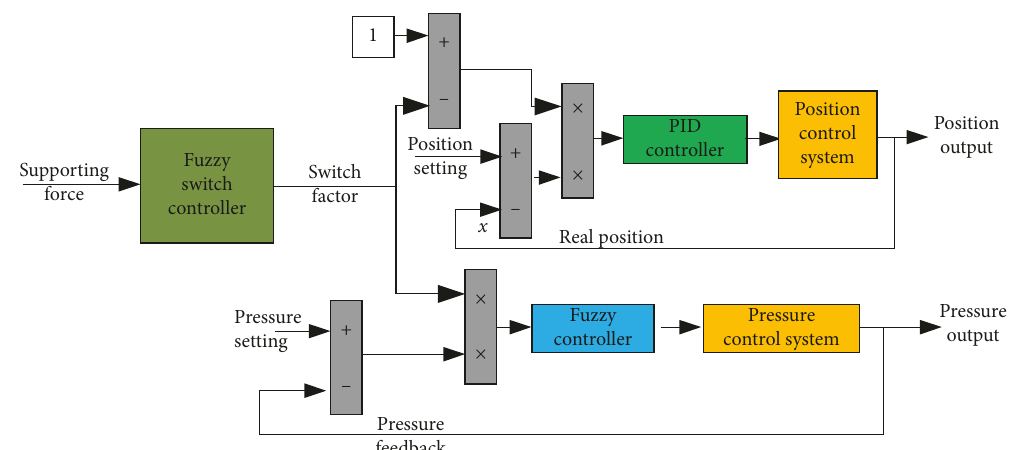
Figure 6: Fuzzy switching control diagram.